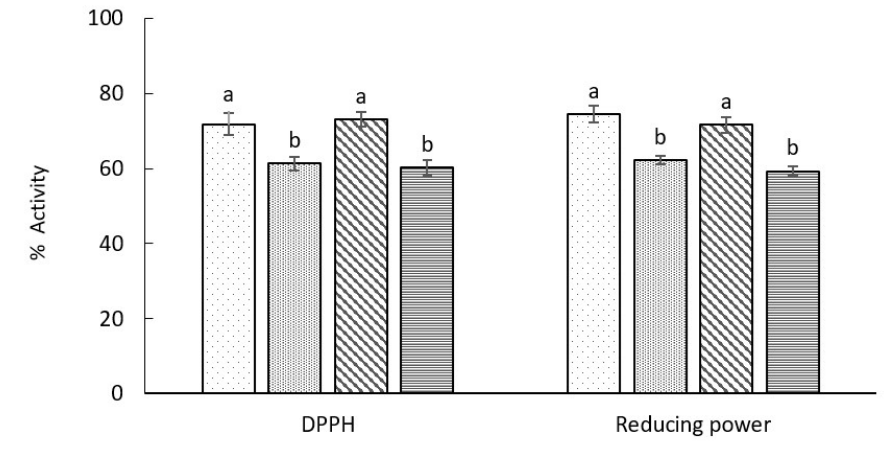
Figure 7. Antioxidant activity of B-Glu (C) and O-Glu (C). Here, B-Glu (C) represents catechin encapsulated into barley and O-Glu (C) represents catechin encapsulated into oats β -glucan matrix. Different letters on the bars representing same sample before and after digestion indicate significant difference ( p <